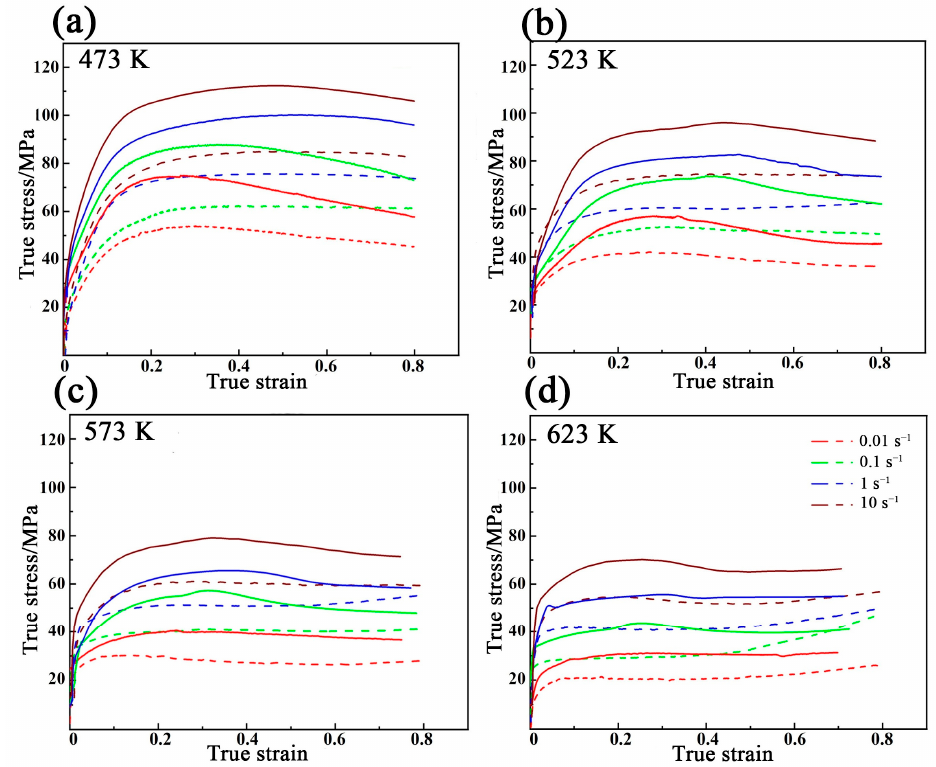
Figure 2. True stress − strain curves of pure Mg and Mg-3Bi alloy at various strain rates with temperature: ( a ) 473 K, ( b ) 523 K, ( c ) 573 K, and ( d ) 623 K.